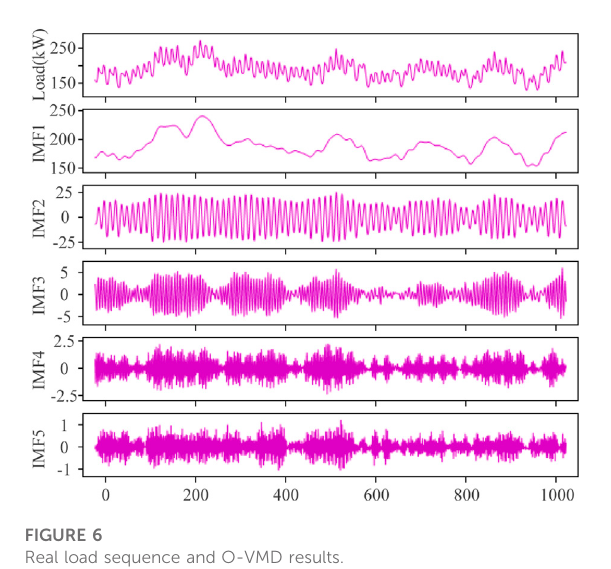
FIGURE 6 Real load sequence and O-VMD